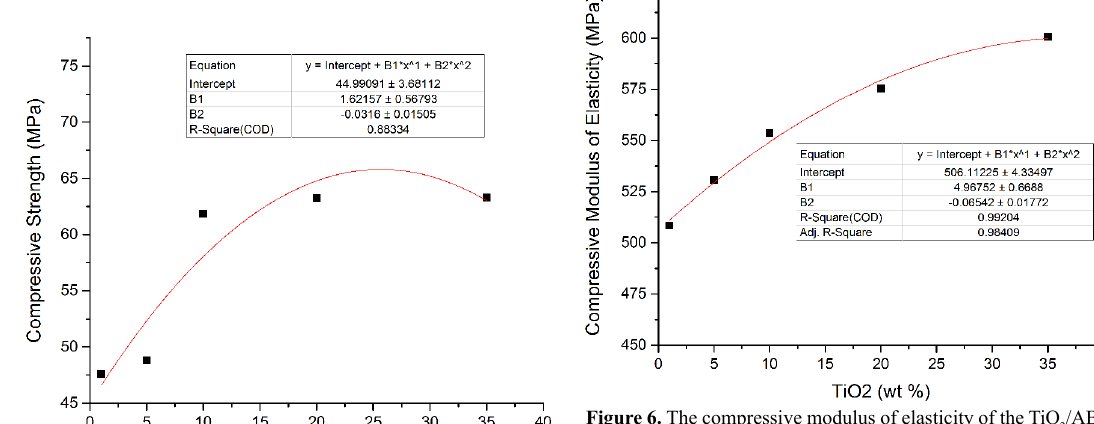
Figure 6. The compressive modulus of elasticity of the TiO composites